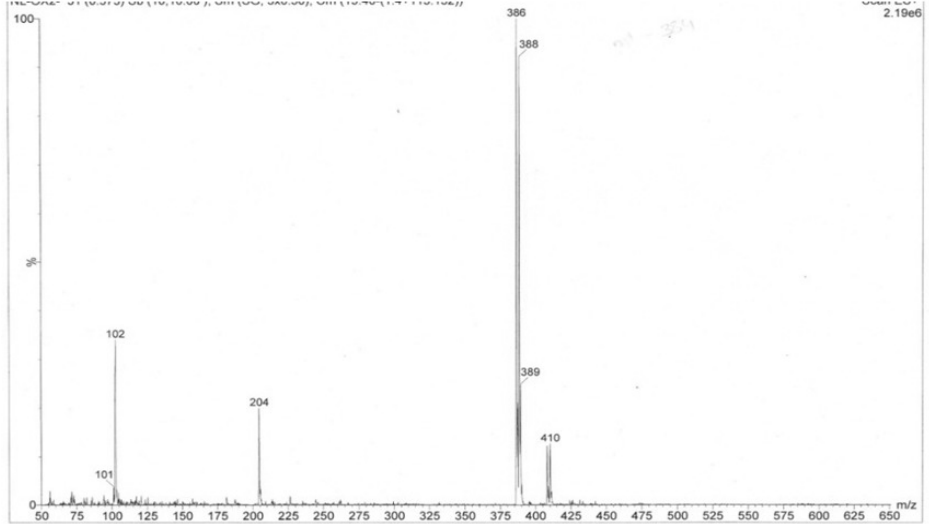
Figure 2. Mass spectra of 5-Br